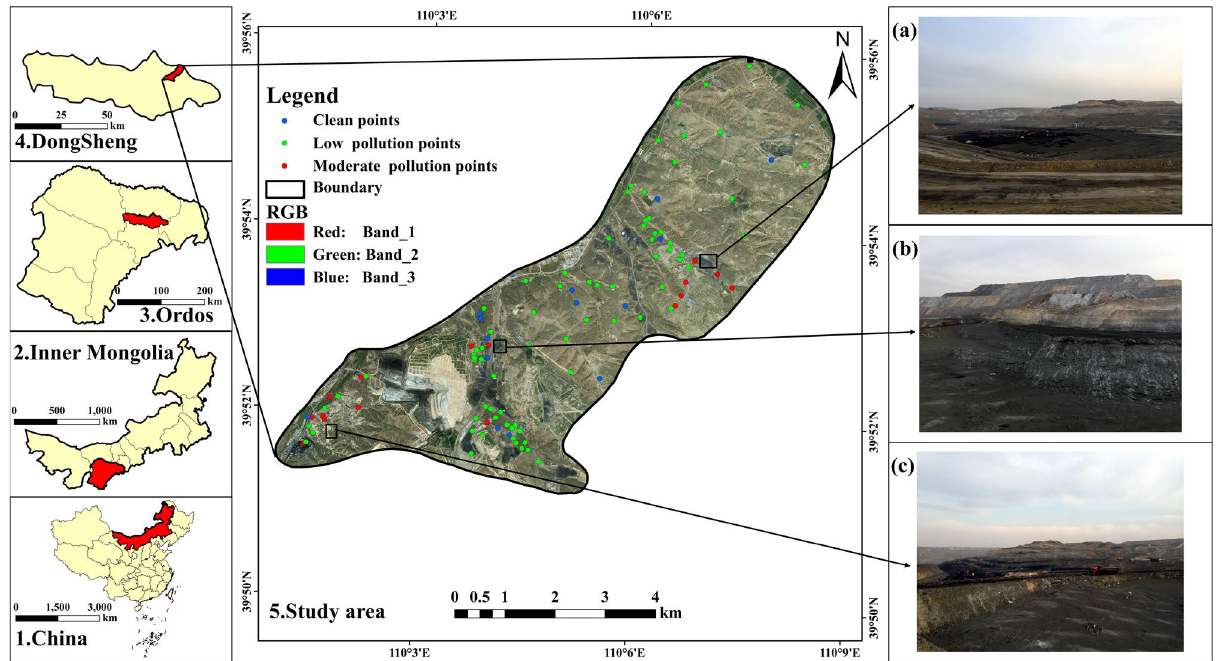
Figure 1. The geographical location of the study area and spatial distribution of the in-situ sampling sites are classified by pollution level. ( a ), ( b ), and ( c ) represent the actual conditions of the study area. (Note: soil samples were classified into three types based on the background value (BV) 15 of the Inner Mongolia Autonomous Region using the contamination factor method 61,62 , including clean (Zn ≤ 48.6 mg kg −1 ), low pollution (48.6 ≤ Zn ≤ 97.2 mg kg −1 ), and moderate pollution (97.2 ≤ Zn ≤ 145.8 mg kg −1 ), respectively. The Fig. 1 was generated by ArCGIS 10.0 that was obtained from https:// www. esri. com/ en- us/ arcgis/ produ cts/ arcgis- deskt op/, and the satelite image used in Fig. 1 (sub Fig. 5) was downloaded from Google Earth (https:// earth. google.